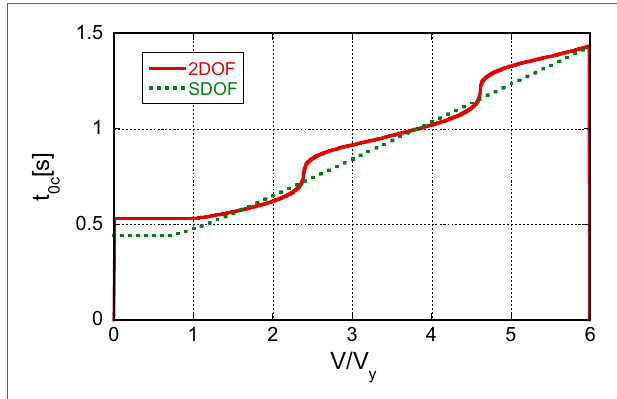
FigUre 13 | critical timing of the second impulse with respect to the input level of double impulse.